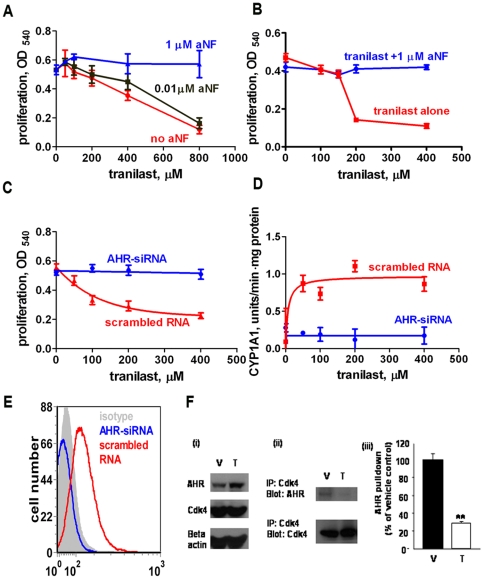
Tranilast's anti-proliferative effect is mediated through AHR stimulation.A. The suppressive activity of tranilast on proliferation of MDA-MB-231 cells was reversed by an AHR antagonist, α-naphthoflavone (aNF). Blockade of tranilast was complete at 1 µM of aNF. B. Blocking effect of aNF on BT474 cell line at a concentration of 1 µM. C. siRNA knockdown of AHR in MDA-MB-231 cells abrogated the antiproliferative effect of tranilast. D. The induction of CYP1A1 expression by tranilast in MDA-MB-231 cells was prevented by AHR knockdown. E. Transfection with AHR-targeted siRNA completely prevented AHR expression by MDA-MB-231 cells as detected by flow cytometric analysis, demonstrating the efficacy of the knockdown procedure. F. Tranilast blocked AHR binding to CDK4. Western blot analysis of lysates of MDA-MB-231 cells grown in conventional DMEM-based medium with vehicle (V) or tranilast (T) (200 µM; 48 h culture) was preformed as described under Materials and Methods. Tranilast enhanced AHR expression, but not CDK4 expression (C i). Immunoprecipitation of lysates of cells grown in vehicle (V) revealed that anti-CDK4 antibody also pulled down AHR, indicating that the two molecules bind to each other, and this binding was significantly disrupted by tranilast (C ii, iii, **p<0.001). These results are representative of 3 experiments.